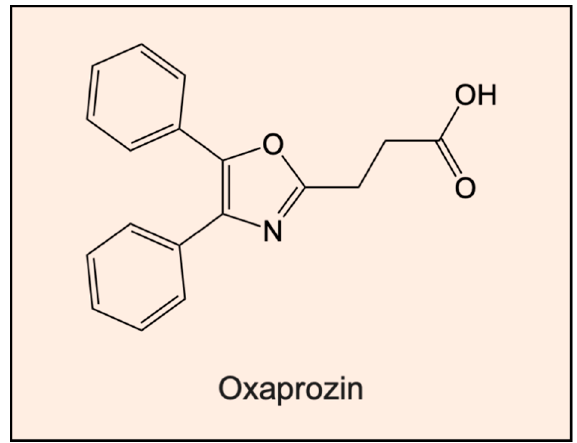
Figure 3. Line drawing of the structure of oxaprozin (4,5-diphenyl-2-oxazolepropionic acid). This agent is also a chelator and a non-steroidal, analgesic, and antipyretic propionic acid derivative that inhibits MMP9 activity by binding zinc(II) [125].